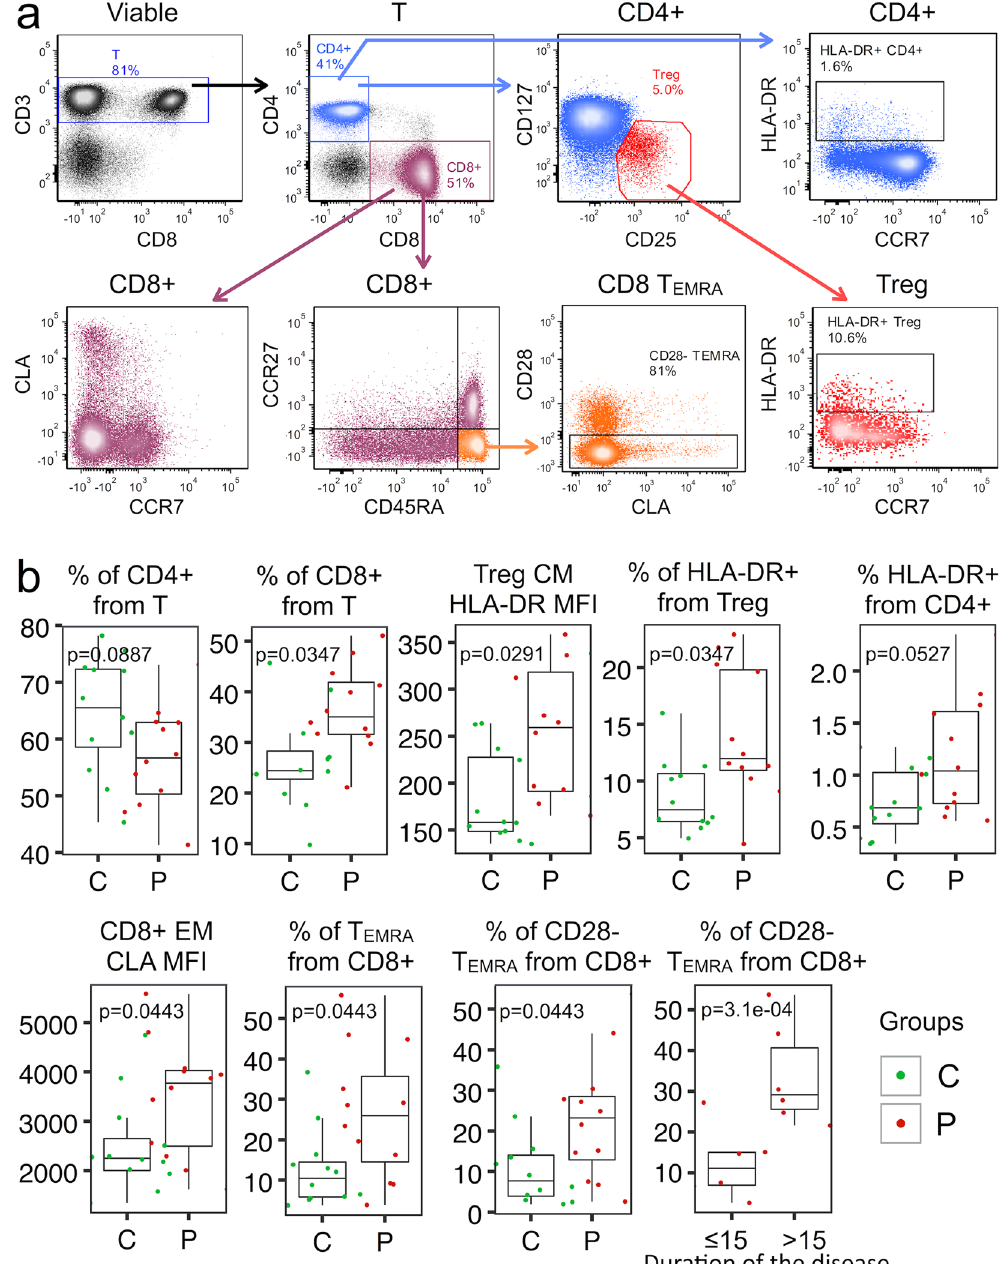
Figure 6. Characteristics of circulating T cell subpopulations in psoriasis patients (P) and control individuals (C). ( a ) Representative FACS plots are shown. More detailed gating strategy can be found in Supplementary Material. ( b ) The box-and-whisker plots depict median (central line), interquartile range (IQR, Q1-Q3, box), Q3 + 1.5 × IQR (upper whisker) and Q1 − 1.5 × IQR (lower whisker). CM – central memory (CCR7 + , CD45RA − ), Treg – regulatory T cell (CD4 + , CD25 + , CD127low) EM – effector memory (CCR7 − , CD45RA − ), CLA – cutaneous lymphocyte antigen, MFI – median fluorescence intensity, T EMRA – effector memory T cell with CD45RA